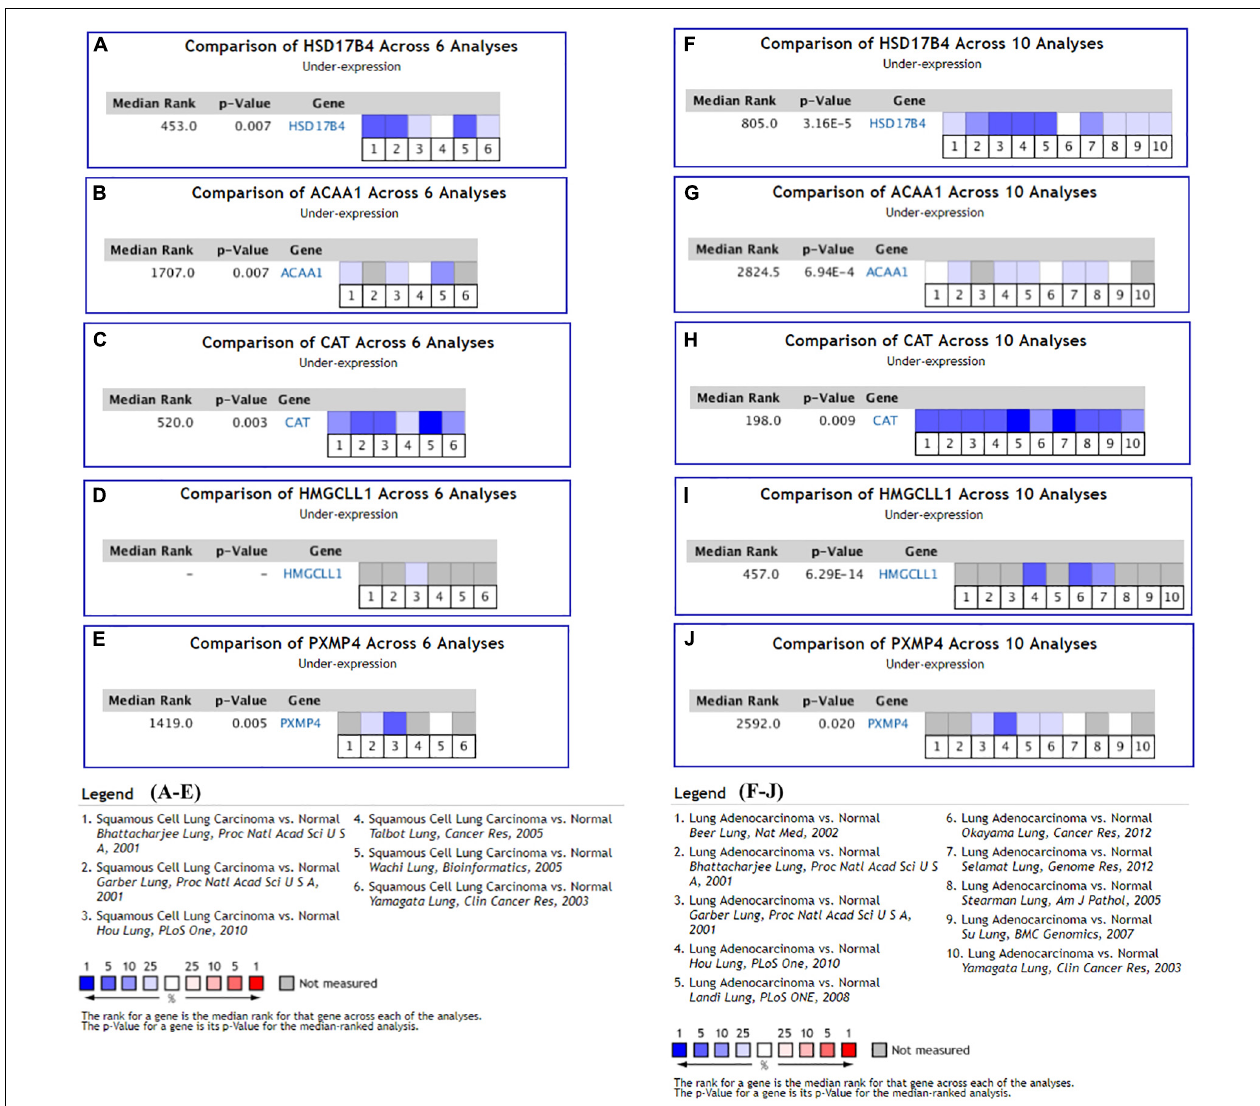
FIGURE 3 | Oncomine meta-analyses of the down-regulated Key CDEPGs (K-DEPGs) in NSCLC. (A–C) Significant overall down-regulation of HSD17B4, ACAA1, and CAT in LUSC. (D) There only one LUSC dataset with the data of HMGCLL1 (Hou lung: fold change = –1.925, p < 0.01, Supplementary Table S1 ) and meta-analysis could not be performed. (E) PXMP4 was significantly down-regulated in LUSC. (F–J) significant overall down-regulation of HSD17B4, ACAA1, CAT, HMGCLL1, and PXMP4 in LUAD. NSCLC, non-small cell lung cancer; LUSC, lung squamous carcinoma; LUAD, lung adenocarcinoma; C-DEPGs, common differentially expressed peroxisome pathway genes. For all the analyses, p < 0.05 was considered significant.